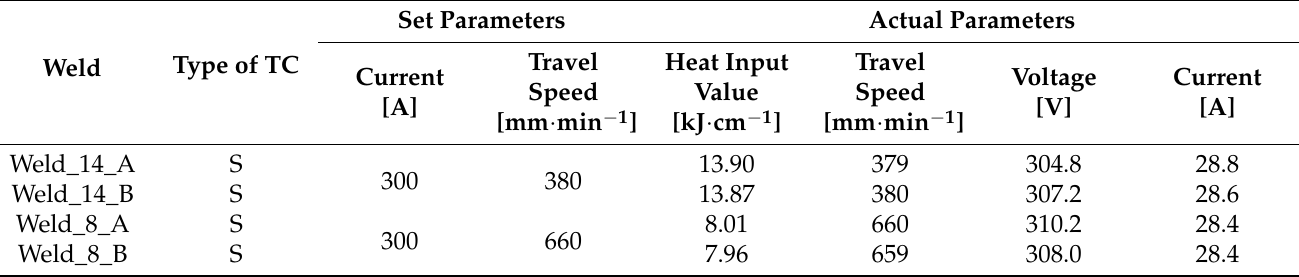
Figure 7. Designed testing sample for measuring the temperature cycles of welds with the heat input value 14 kJ·cm − 1 . Table 5. Process parameters of welds with heat input values 8 and 14 kJ·cm − 1 .